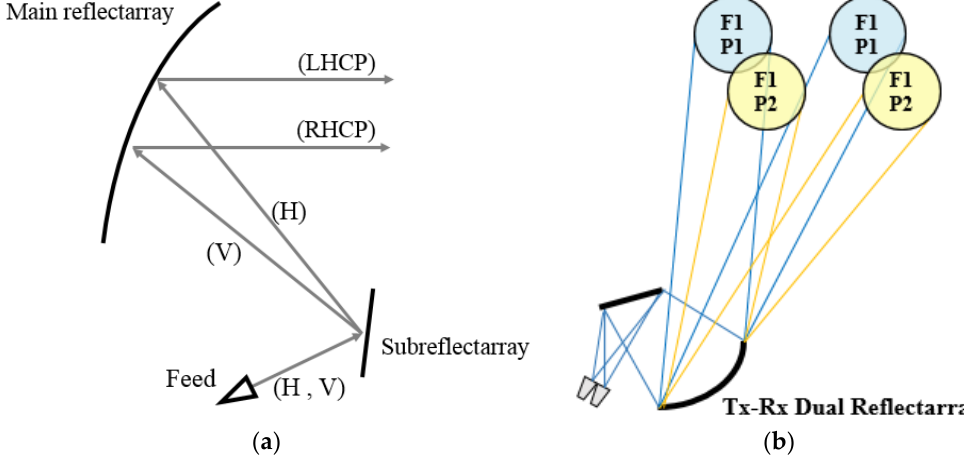
Figure 10. Dual reflectarray system proposed to operate simultaneously in Tx and Rx. ( a ) Operating principle of the dual-configuration, ( b ) functional scheme of the proposed antenna on the satellite.